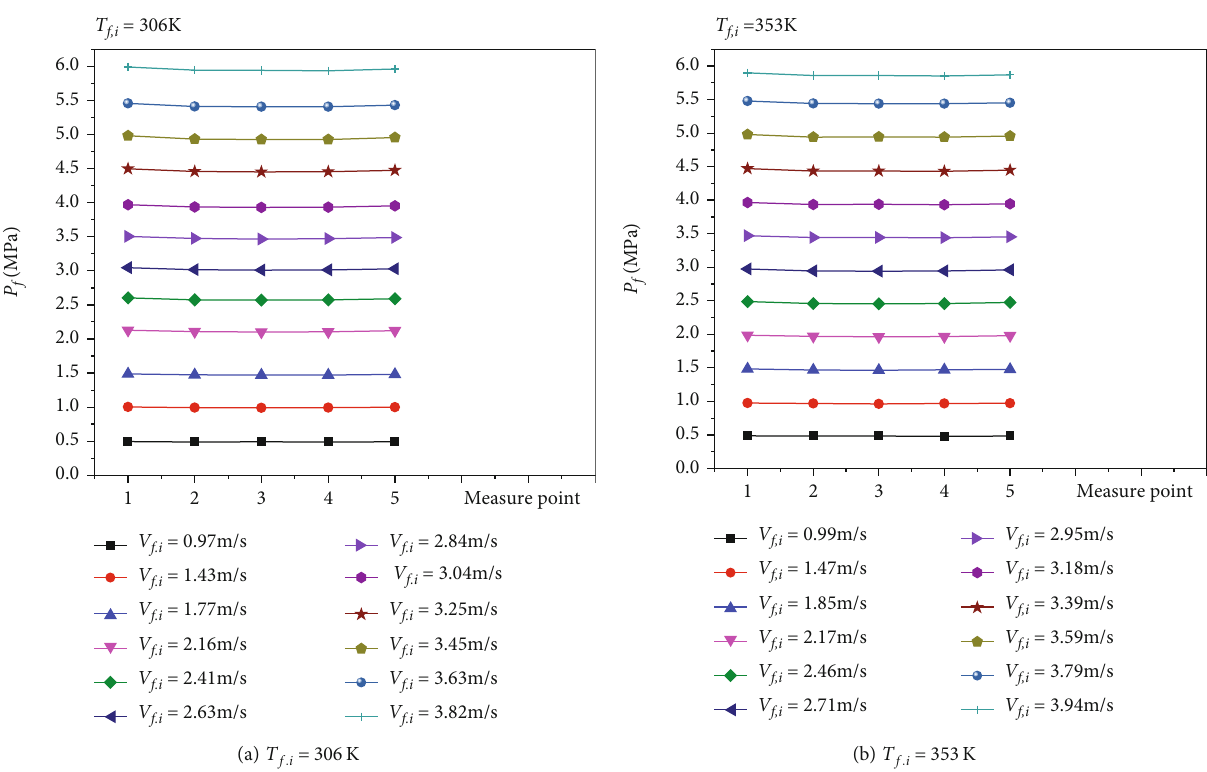
Figure 12: Pressure distribution of main path.